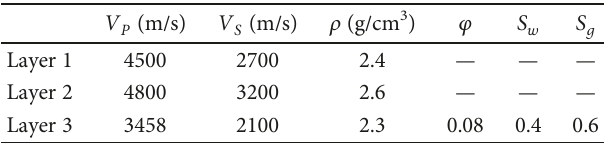
Figure 1: A horizontally layered medium model. The top two layers are nonreservoir and are regarded as elastic medium. The bottom layer is gas-bearing reservoir and poroelastic medium is adopted to represent it. Table 1: The parameters of layered medium